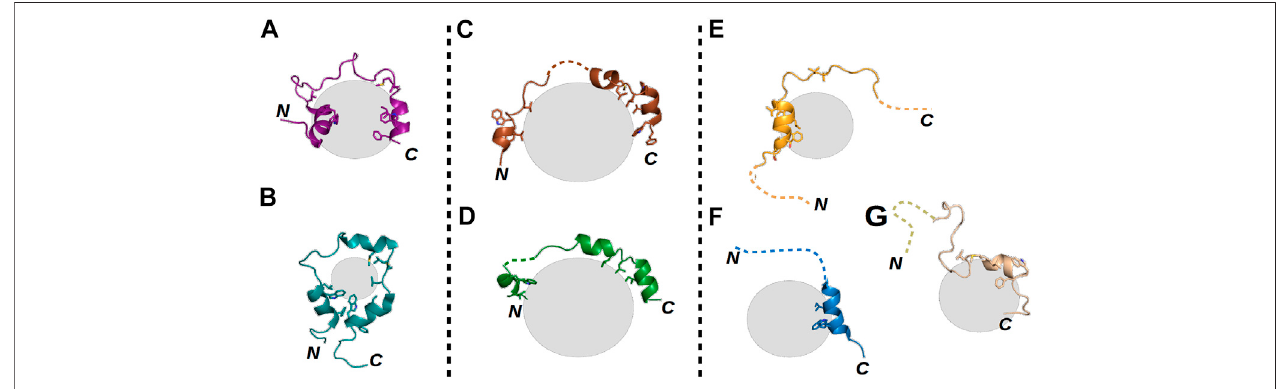
FIGURE1| Structuralillustrationsofvariousfuzzyinteractionsmadebythep53TAD.Grayspheresrepresentthedifferentpartnerproteins,thelabelsNandCmark the locations of the termini of each p53 TAD chain, and dashed lines represent highly fl exible disordered regions of the TAD in the respective complexes. (A) TAZ – p53 TAD 1 – 56 (PDB ID: 5HOU) (Krois et al., 2016) and (B) CRB – p53 TAD 13 – 61 (PDB ID: 2L14) (Lee et al., 2010) complexes represent polymorphic interactions, where nearly thewholeTADisboundwithfewalternativeconformations. (C) S100P – p53TAD 17 – 56 (PDBID:7NMI)and (D) S100A4 – p53TAD 17 – 56 (PDBID:6T58)(Ecsédietal., 2020) complexes show the characteristics of clamp-like fuzzy interactions where the TAD is anchored at several binding points, while the linking regions remain fl exible and appear in numerous conformations. Finally, (E) p300 – p53 TAD 1 – 39 (PDB ID: 2K8F) (Feng et al., 2009), (F) TFIIH – p53 TAD 1 – 55 (PDB ID: 2GS0) (Di Lello et al., 2006), and (G) HMGbox – p53 TAD 1 – 93 (PDB ID: 2LY4)(Rowellet al., 2012)complexes aregood examples of fl ankingfuzzy interactions. Here,only asmall portion oftheTADis binding the partner, while the sequences of the N- and C-termini remain disordered without any con fi nable